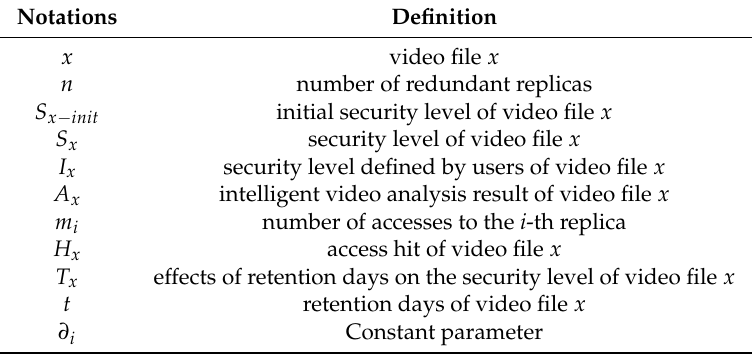
Table 1. Notations Definition.